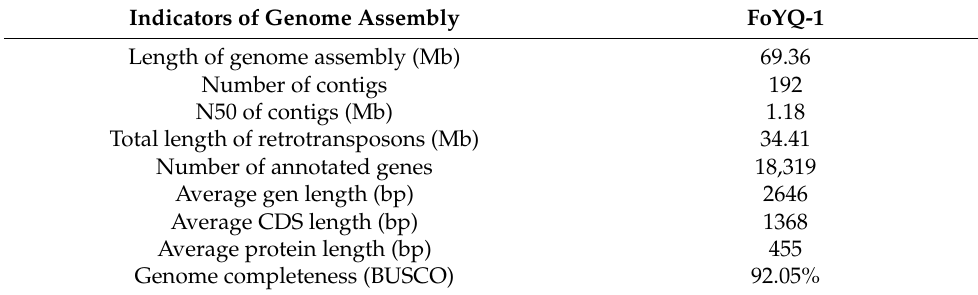
Table 2. Statistics of the FoYQ-1